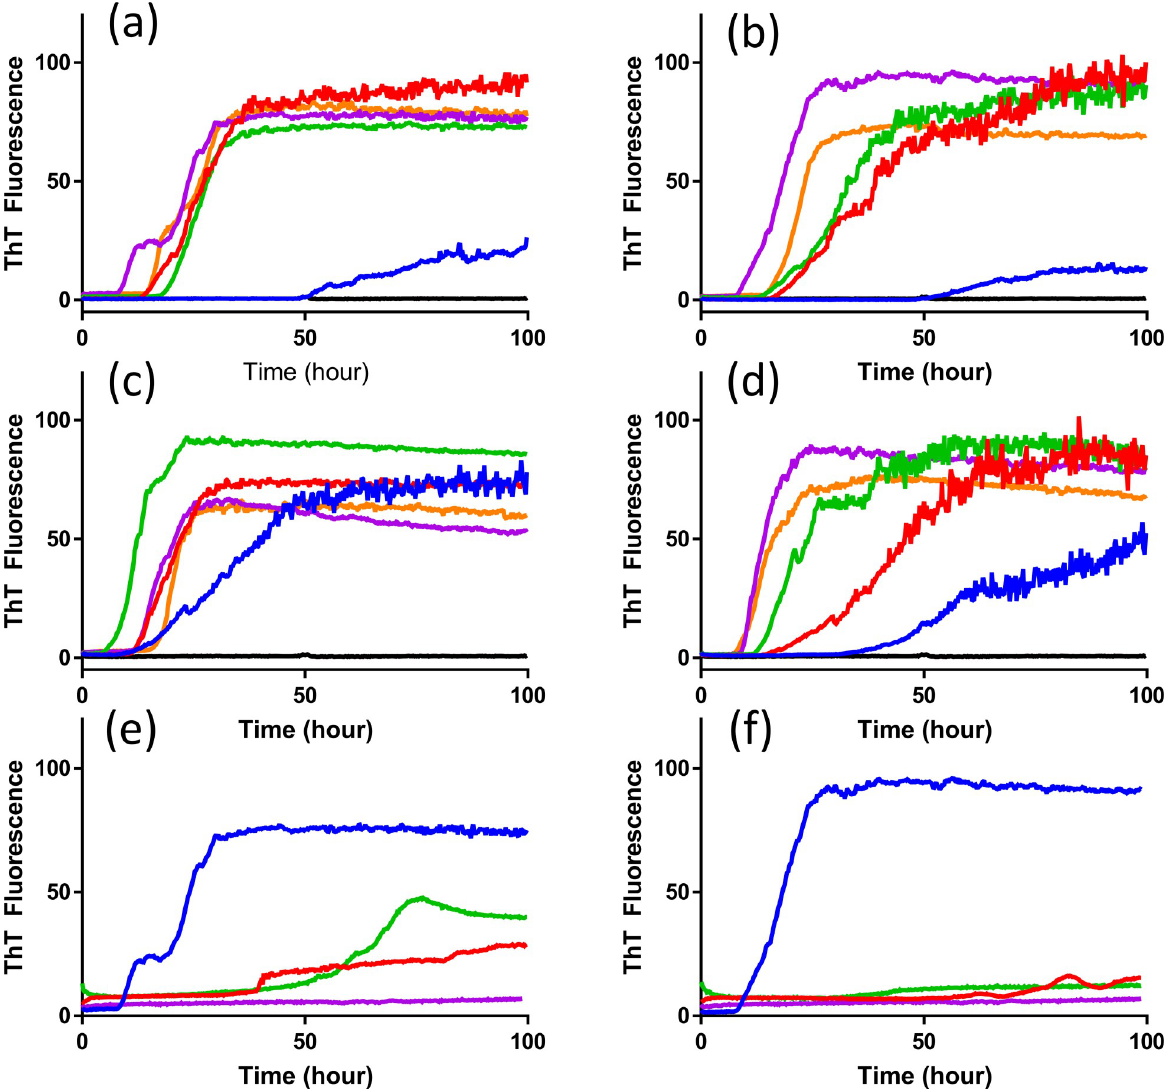
Fig 5. RT-QuIC sodium chloride and SDS titration for 13–7 scrapie-infected and uninfected sheep brain samples. RT-QuIC reactions were seeded with 10 − 2 brain homogenate of animal number 5 (VRQ/VRQ;13–7) and 7 (ARQ/ARQ; 13–7) using full-length elk prion protein 132L (a and c) and 132M (b and d) using a range of NaCl concentrations (100–500 mM, 100 mM: blue, 200 mM: red, 300 mM:green, 400 mM: purple, 500 mM: orange line). Uninfected sheep brain samples showed no increase in ThT regardless of NaCl concentration and the individual curves are not distinguishable as individual curves and appear as a thick dark line near 0% Maximum ThT Fluorescence (a, b, c, and d). RT-QuIC reactions were also seeded with 10 − 2 dilutions of 13–7 scrapie-infected sheep (animal #5) and negative control (uninfected sheep) brain homogenates using either mature elk prion protein 132L (e) or 132M (f) protein (aa 23–231) as substrates without SDS (blue line), with the addition of 0.001% (red line) or 0.002% SDS (green line) in the presence of 400 mM NaCl. Negative control is shown in purple for both substrates with 0% SDS and 400 mM NaCl. Data are presented as mean ThT fluorescence of 4 technical